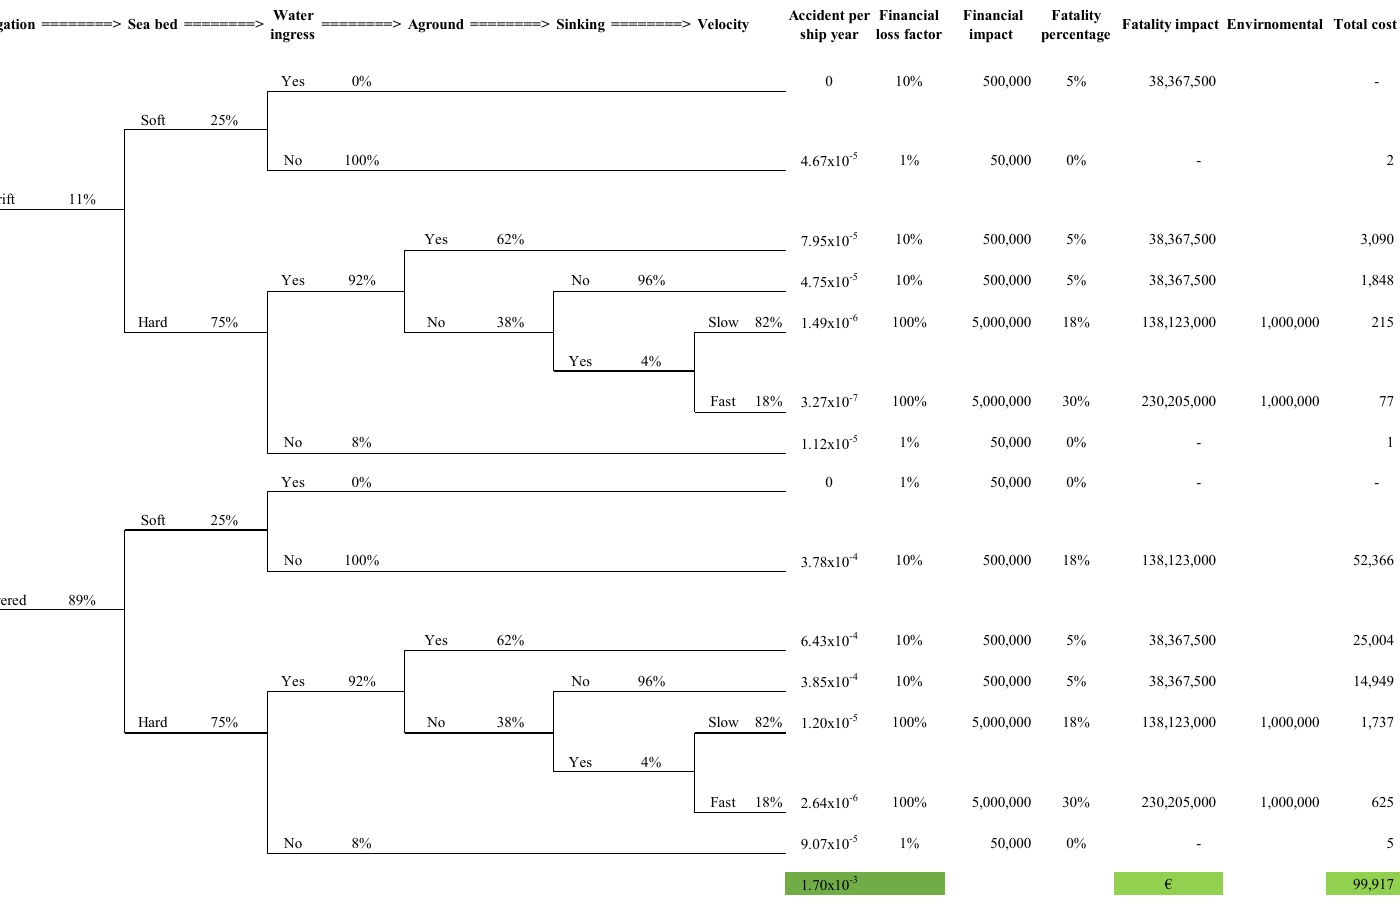
Figure 17. Event tree analysis of grounding for the ferry in this study.